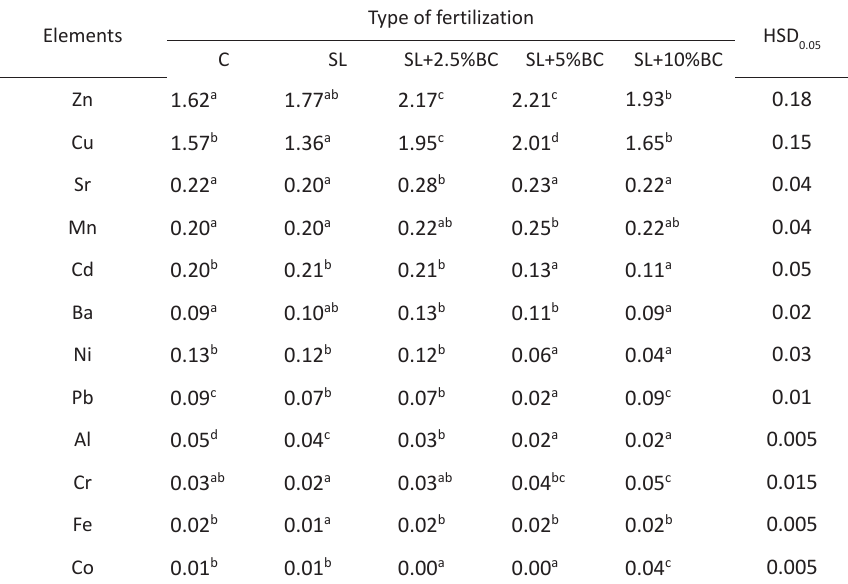
Table 4. Accumulation Index (AI) calculated according to the following formula: AI element; GC–total concentration in grain; SC–total concentration in